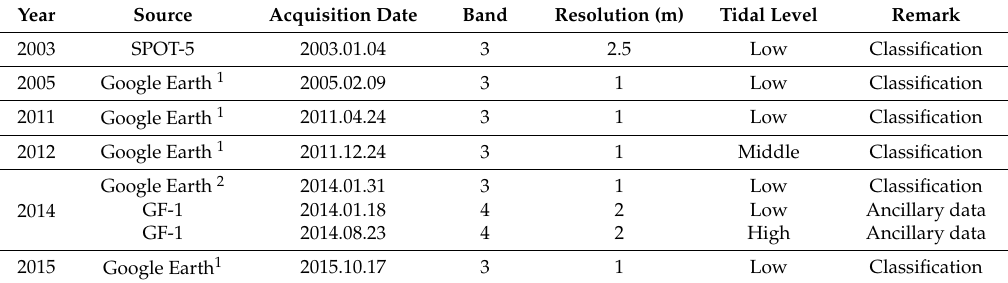
Table 1. Characteristics of the selected high-resolution